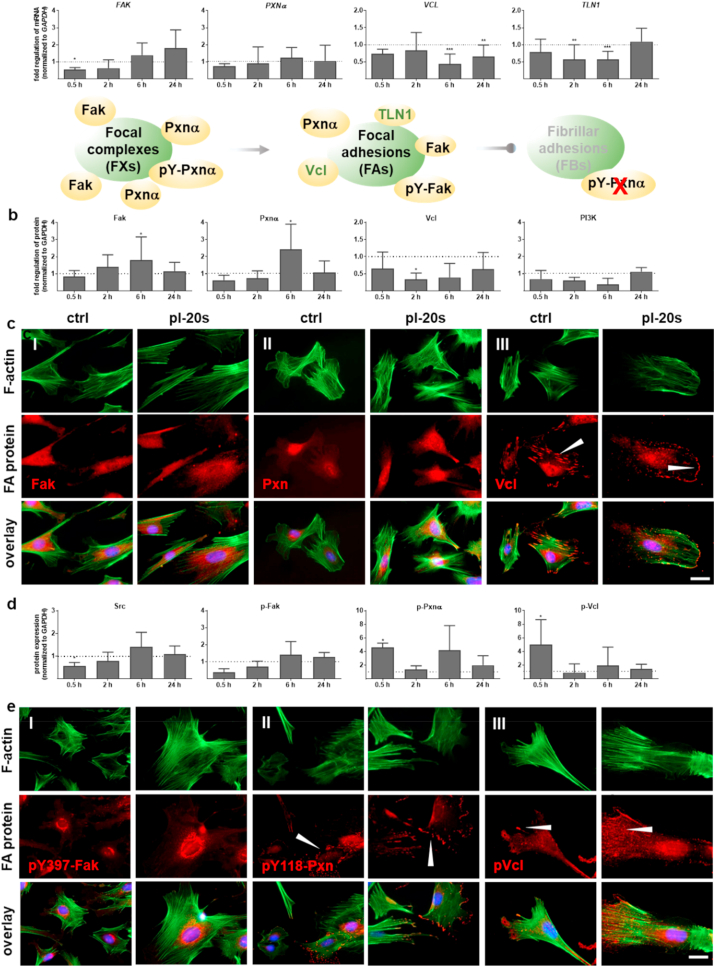
Gas plasma treatment modulated signaling and scaffolding proteins that link the integrin receptors to the actin cytoskeleton. (a) Gene expression levels of focal adhesion kinase (FAK), paxillin α (PXNα), vinculin (VCL), and talin (TLN1) were determined by qPCR. Scheme of focal adhesion complexes with associated protein targets. (b, d) Protein quantification of the non-phosphorylated proteins and activated pFak, pPxn, pVcl as well as tyrosine kinase (Src) and phosphoinositide-3-kinase (PI3K) were determined by Western blot analysis in relation to incubation time with gas plasma-treated medium as indicated. Data were normalized to GAPDH and untreated controls (ctrl) at indicated time points (n > 5) and presented as mean +SE. Statistical analysis was done by unpaired two-tailed Student's t-test with significances of *p < 0.05, **p < 0.01, and ***p < 0.001. (c, e) pDFs were grown on glass coverslips, incubated with gas plasma-treated medium (pl-20 s), fixed, and subjected to fluorescent staining for determination of expression and distribution of FA proteins (red) such as anti-Fak (I), anti-Pxn (II), anti-Vcl (III, arrowheads show vinculin positive cellular protrusions), and their phosphorylated counterparts in (e) with anti-pY397-FAK (I), anti-p-Pxn (II), and anti-pVcl (III). The cell nuclei were stained with DAPI (blue). Scale bars are 50 μm. (For interpretation of the references to color in this figure legend, the reader is referred to the Web version of this article.)